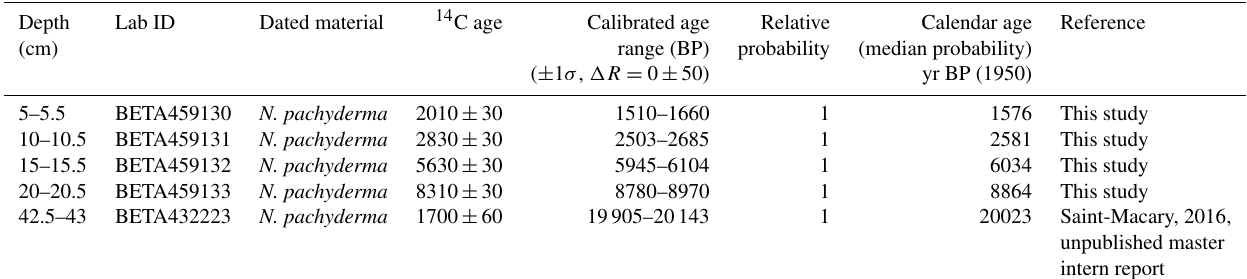
Table 1. AMS 14 C dates from GS15-198-62MUC-A, and calibrated calendar ages. All dates were calibrated using Calib 7.10 (Stuiver et al., 2017), the Marine13 calibration dataset, and a (cid:49)R = 0 ± 50. N. pachyderma = Neogloboquadrina pachyderma . Median probability ages are used as tie points when calculating the age model, based on linear interpolation between these tie